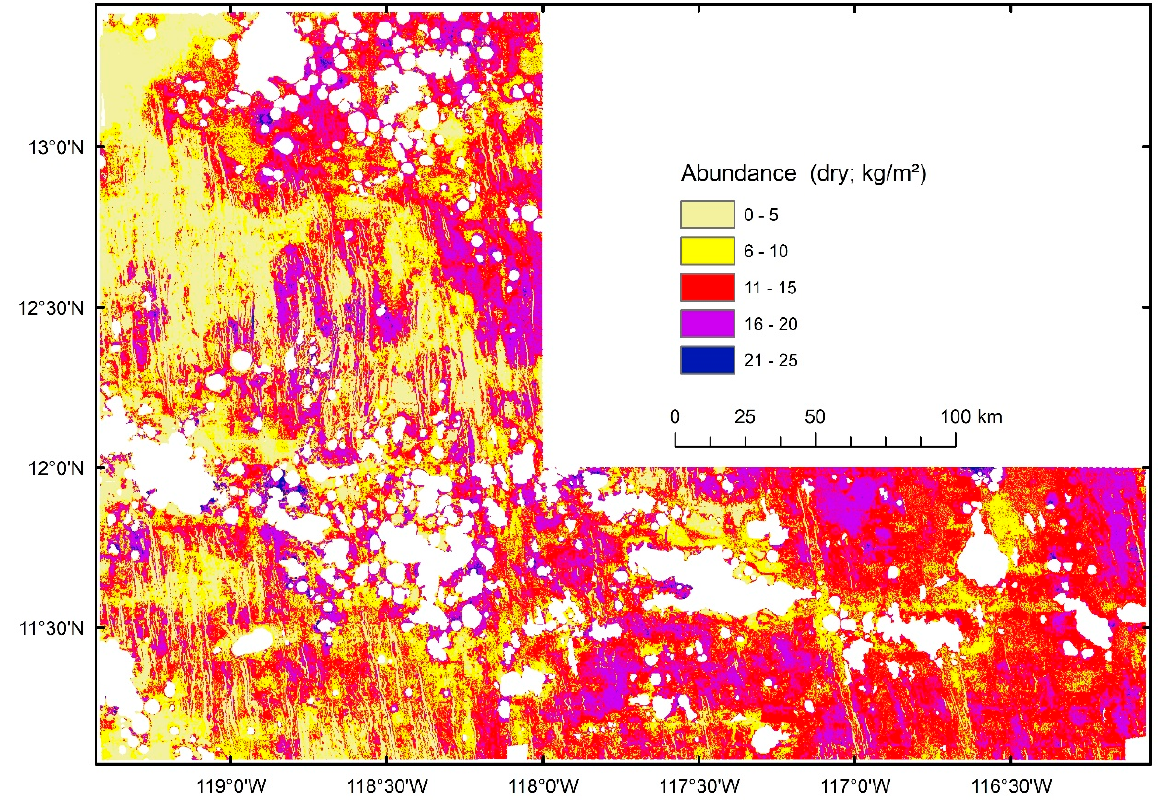
Figure 13. Modelled distribution of the Mn nodule abundance on dry weight basis in the eastern contract area. Seamounts are masked out (white areas). Contiguous areas with high abundance above 16 kg/m 2 are indicated in violet and blue.